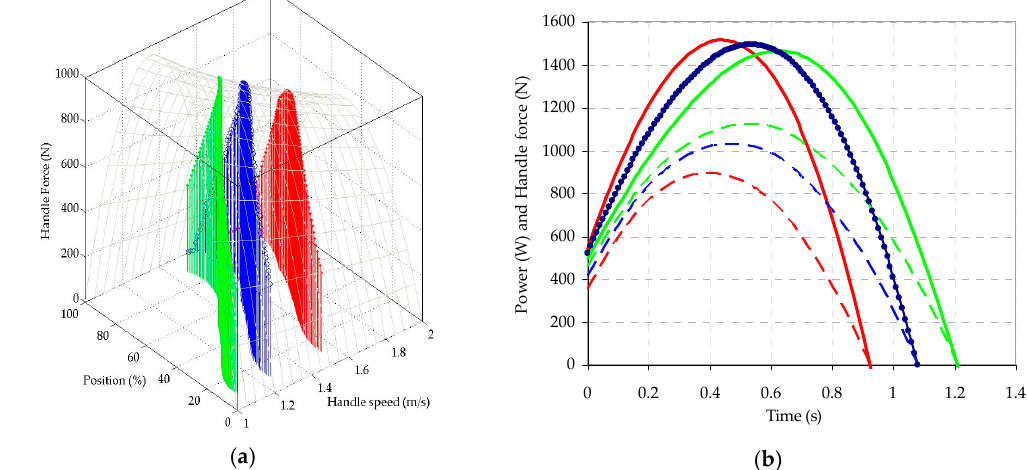
Figure 3. Effect on ergometer aerodynamic resistance on the coupled athlete F-v-l model—ergometer resistance model. Different ergometer aerodynamic resistances ( k ) of 0.0005 (red), 0.001 (blue, as in Figure 2), and 0.0015 (green) are shown. ( a ) 3D ( F-v-l ) trajectory of the handle force and velocity through the rowing stroke. In light grey is the envelope of the athlete’s ( F-v-l ) available output. ( b ) Time evolution of applied power (solid lines) and handle force (dashed lines) through a